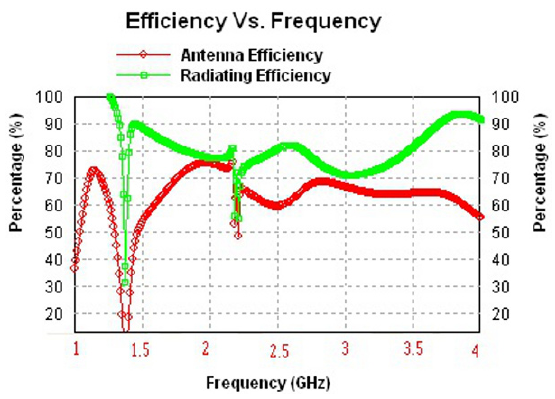
Figure 6. Efficiency Vs frequency plot of slotted microstrip